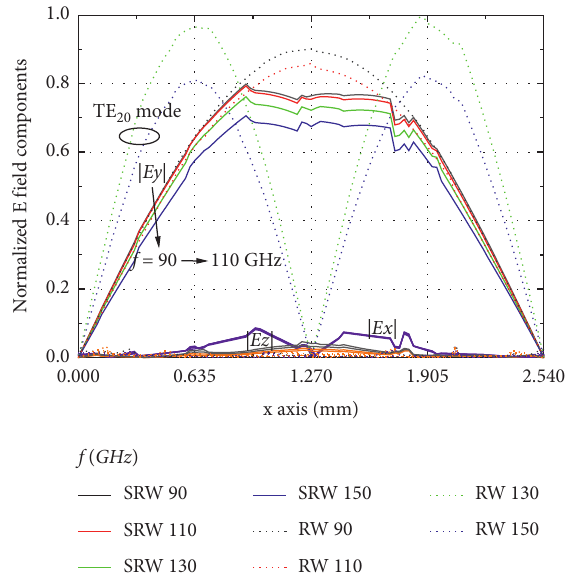
Figure 4: Normalized E field components distribution of SRW: (a) normalized | H x | and | H y | field components distribution and (b) normalized | H z | field component